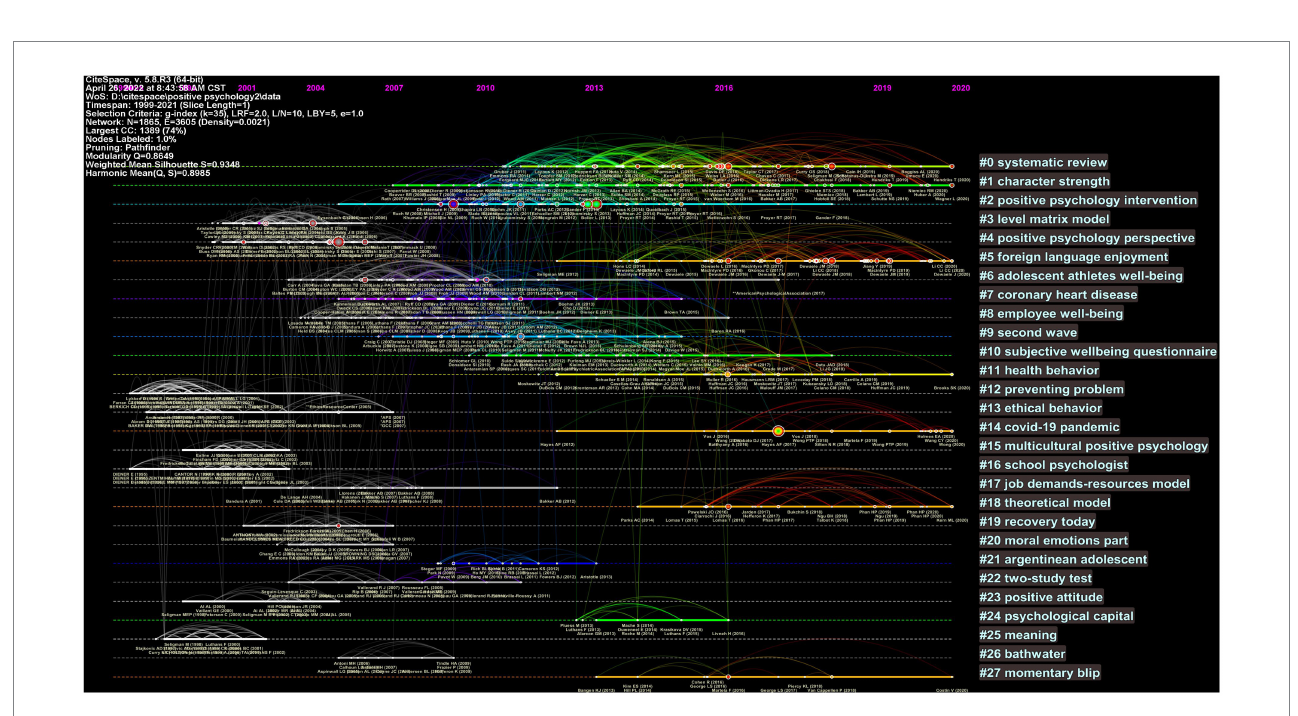
FIGURE 8 Timeline view in positive psychology